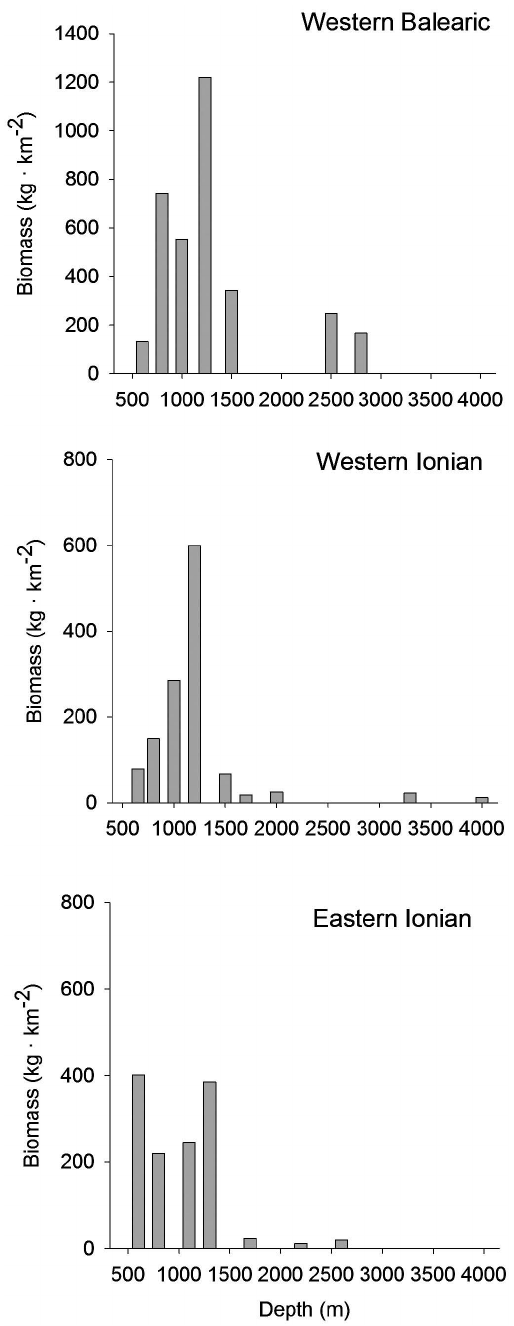
Fig . 5. – Standardized values of total catch biomass for the western Balearic Sea, the western Ionian sea (including the two central abys- sal plain samples), and the eastern Ionian Sea.